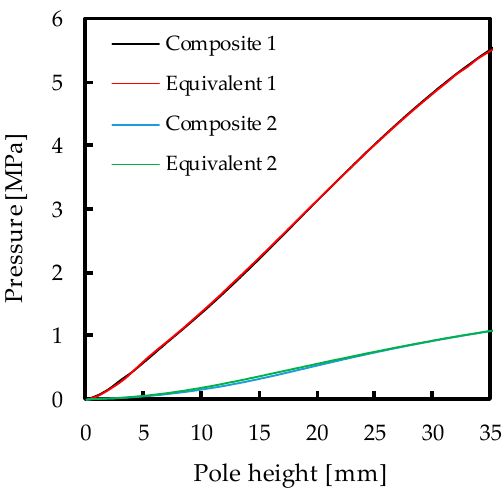
Figure 6. Pressure vs. pole height evolutions for the two composites and the respective equivalent materials, confirming the overlapping.